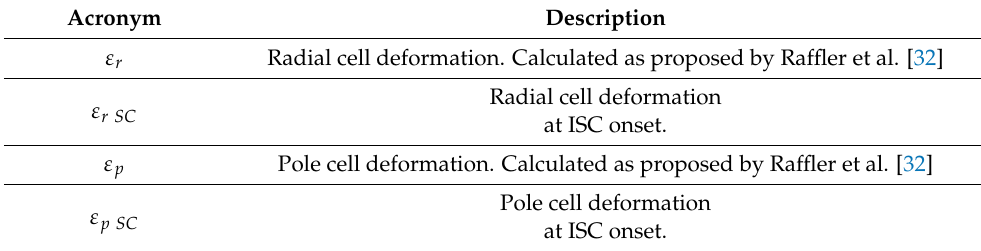
Table 1. Description of the acronyms for the ISCR at the cell level.